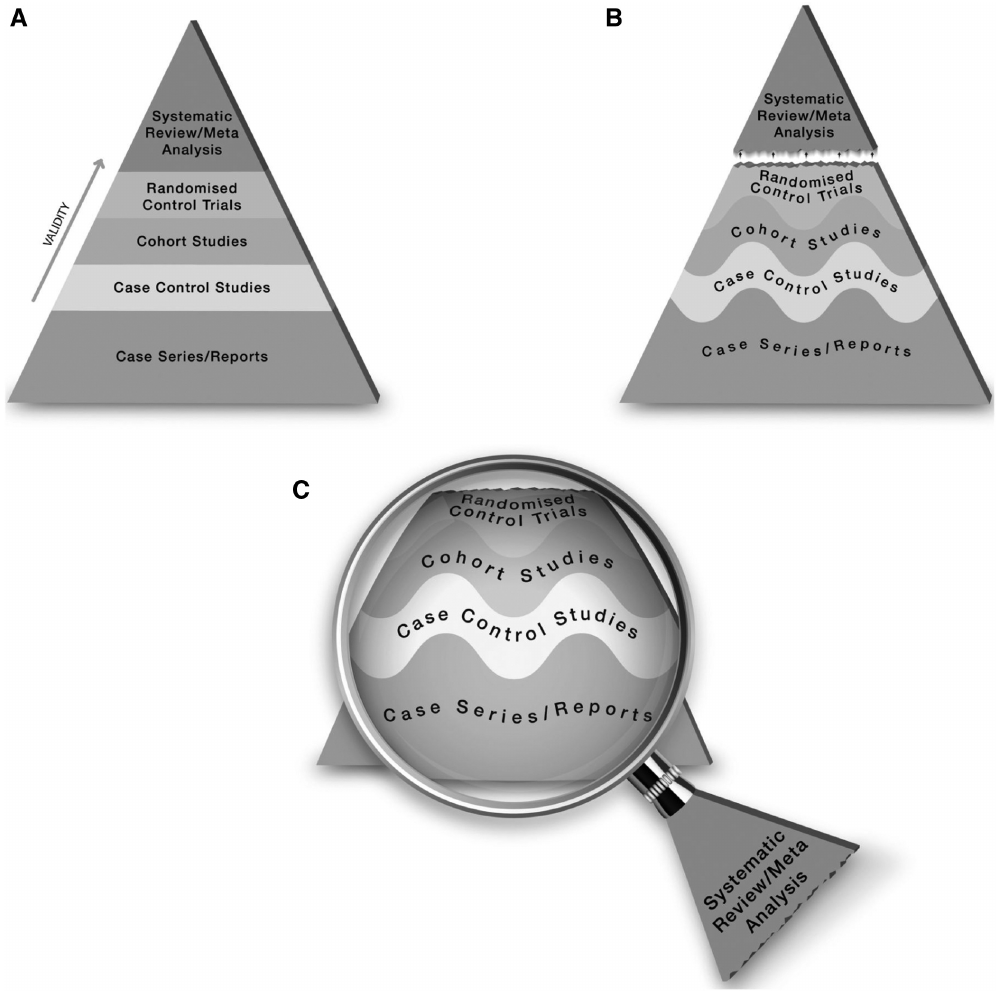
Figure 1: The evidence